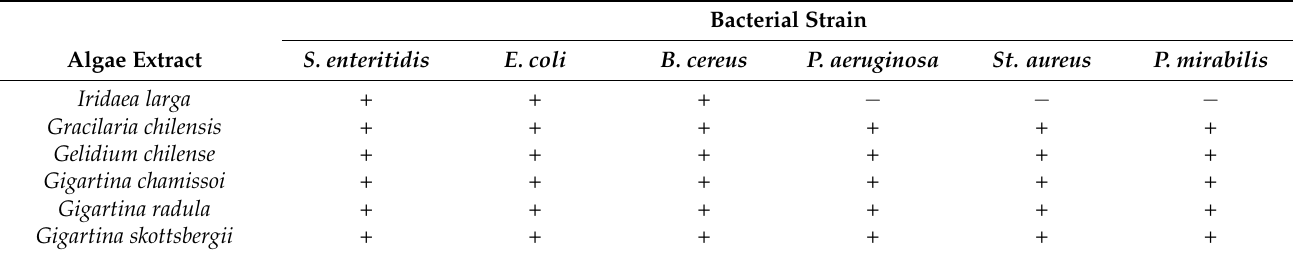
Table 3. Detected antimicrobial reactions of assessed algae extracts. Bacterial